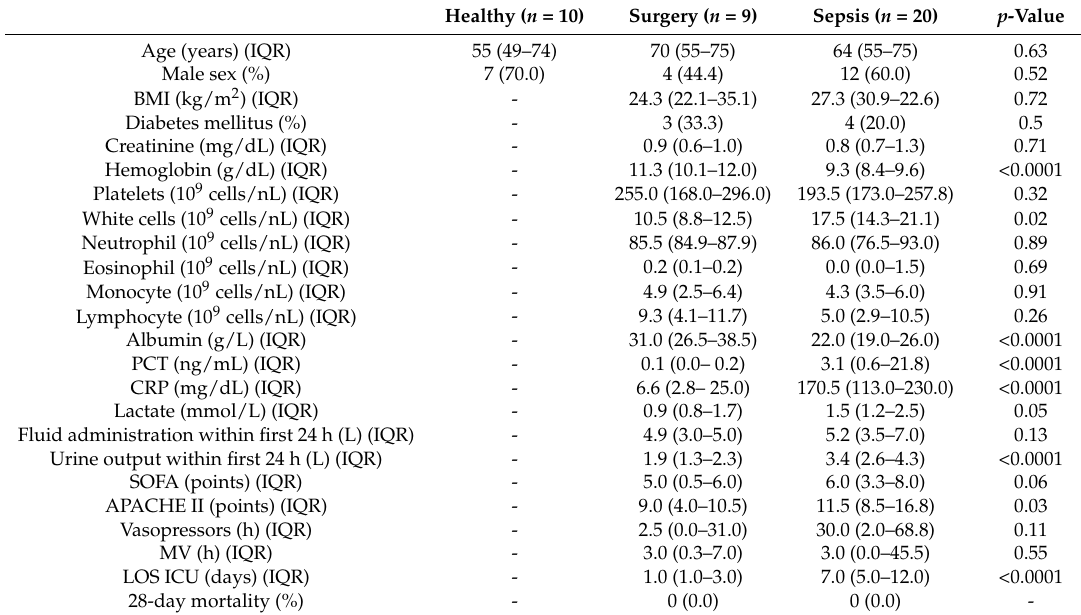
Table 1. Patients’ characteristics.